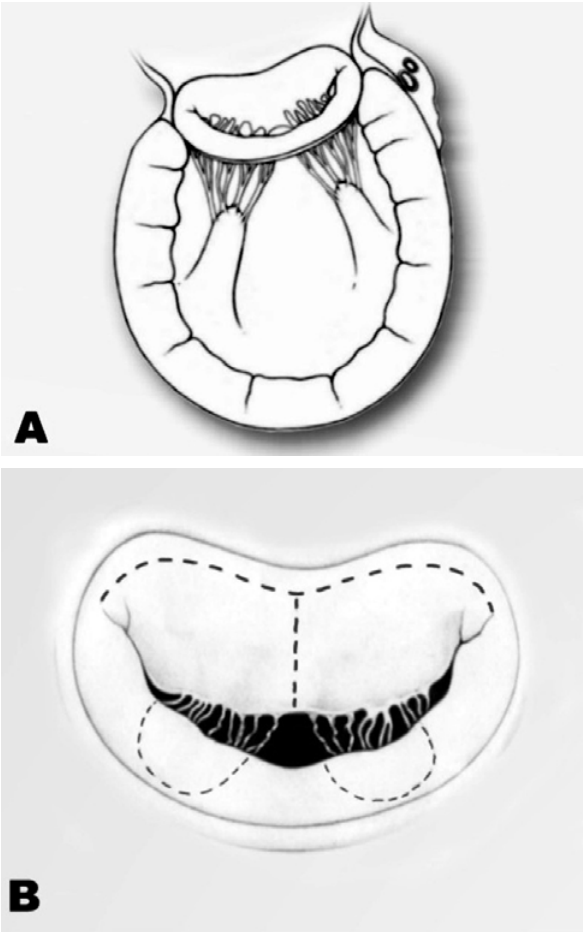
Fig. 1 - A: Anatomia do aparato subvalvar mitral. B: Anatomia da valva mitral: linhas de